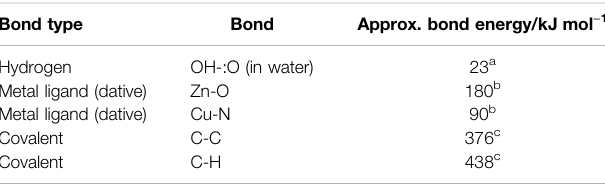
TABLE 1 | Table of example relative bond strengths, highlighting the intermediate nature of metal ligand dative covalent